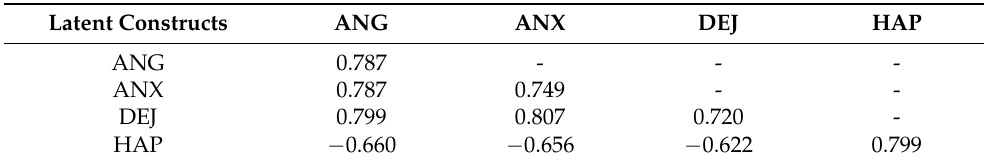
Table 6. Discriminant validity results (Fornell–Larcker criterion). Table 5. Reliability and convergent validity results.